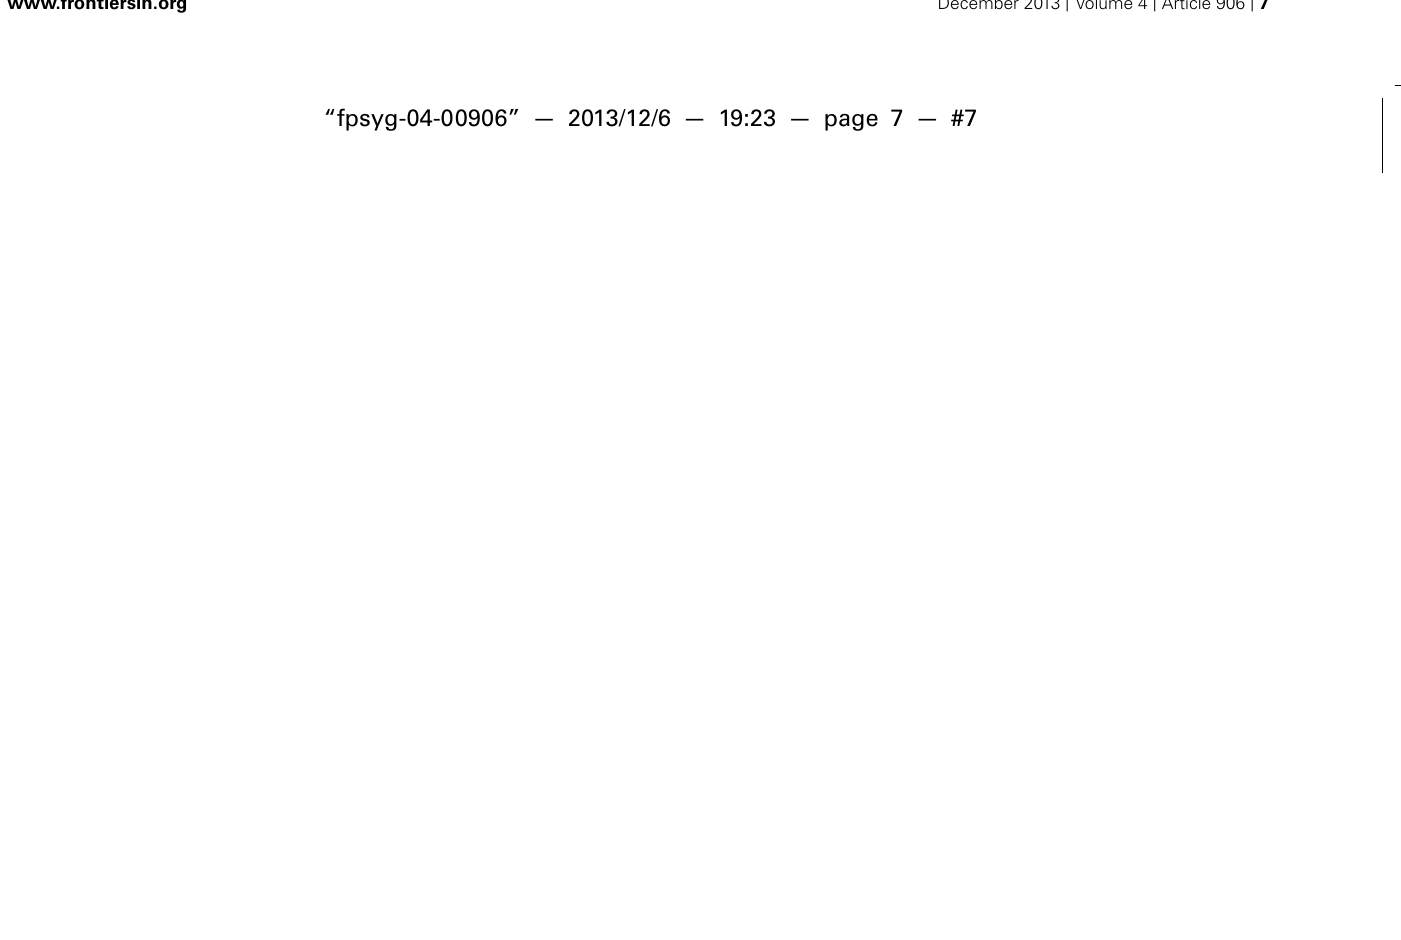
the male reader (M) in the different speaking conditions – loud (L), normal (N), and slow (S). The two readers showed different breathing behavior according to the parameter and the condition (see text for